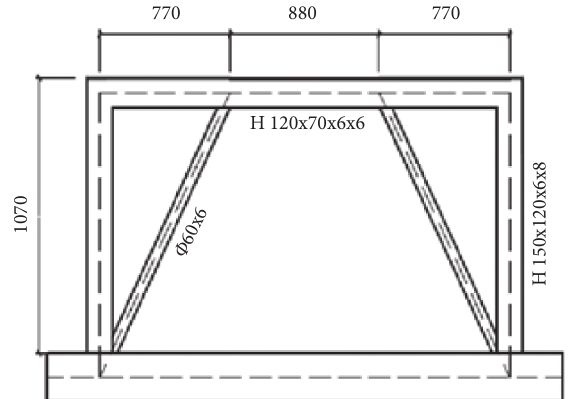
Figure 17: Geometric characteristics and sections used in the experiment by Shi et al. [29].